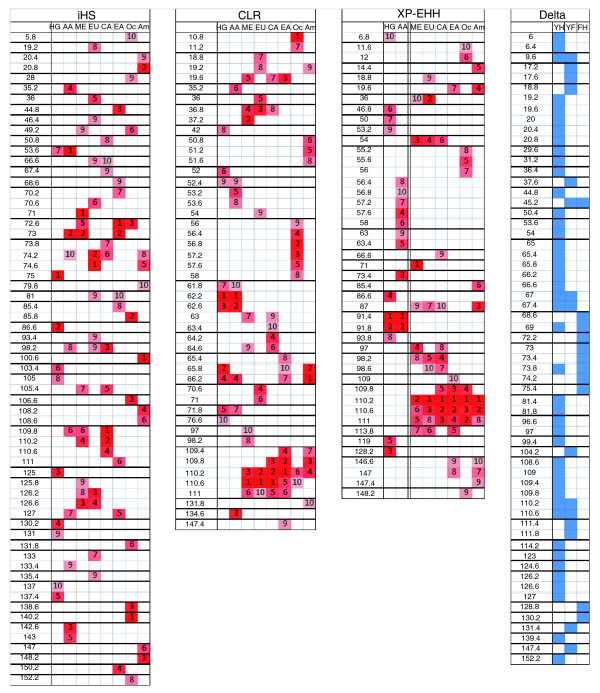
Top ten regions for iHS, CLR, and XP-EHH scores and all high-delta regions. The numbers on the left side of each figure represent the beginning position of a region in megabases. Each chromosomal region is 400-kb in length. The letters across the top of each figure represent the eight continental regions: HG, hunter-gatherer; AA, African agriculturist; ME, Middle East; EU, Europe; CA, Central Asia; EA, East Asia; Oc, Oceania; Am, America. In the delta figure, the column labels represent the three population comparisons: YH, Yoruba-Han; YF, Yoruba-French; FH, French-Han. For iHS, CLR, and XP-EHH, each small column contains the numbers 1 to 10 denoting the top ten X-chromosomal regions for each particular test and continental group with the intensity of the color corresponding to the rank. For XP-EHH, the double line separating the African agriculturist column from the Middle East column signifies that the XP-EHH scores represented on the left side of the lines were calculated using East Asians as the reference sample while the scores represented on the right side of the lines were calculated using African agriculturists as the reference sample (Additional file 9). For delta, each blue shaded region contains either a high-delta SNP for the Yoruba-Han or Yoruba-French comparison, or a SNP with delta > 0.8 for the French-Han comparison.